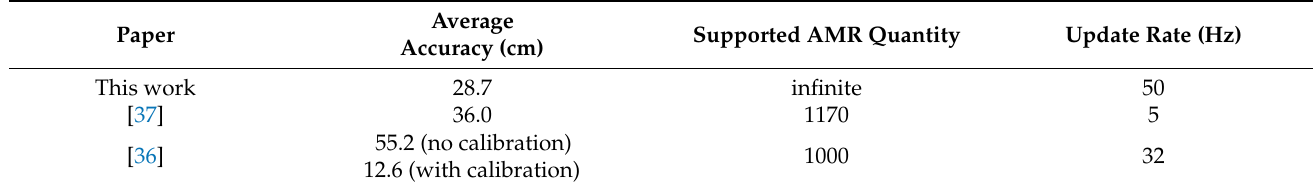
Table 1. Features comparisons for UWB-related